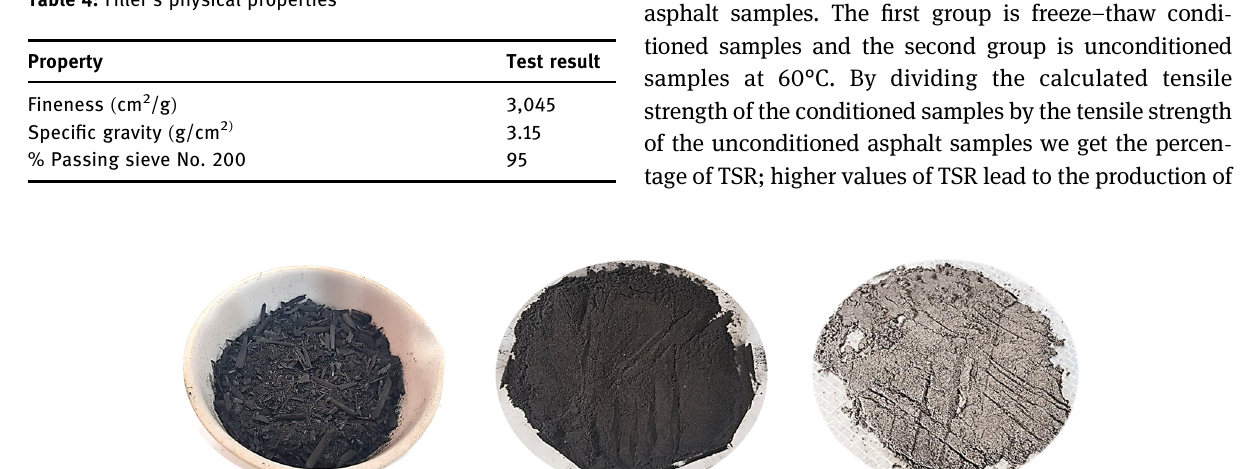
Table 4: Filler ’ s physical properties